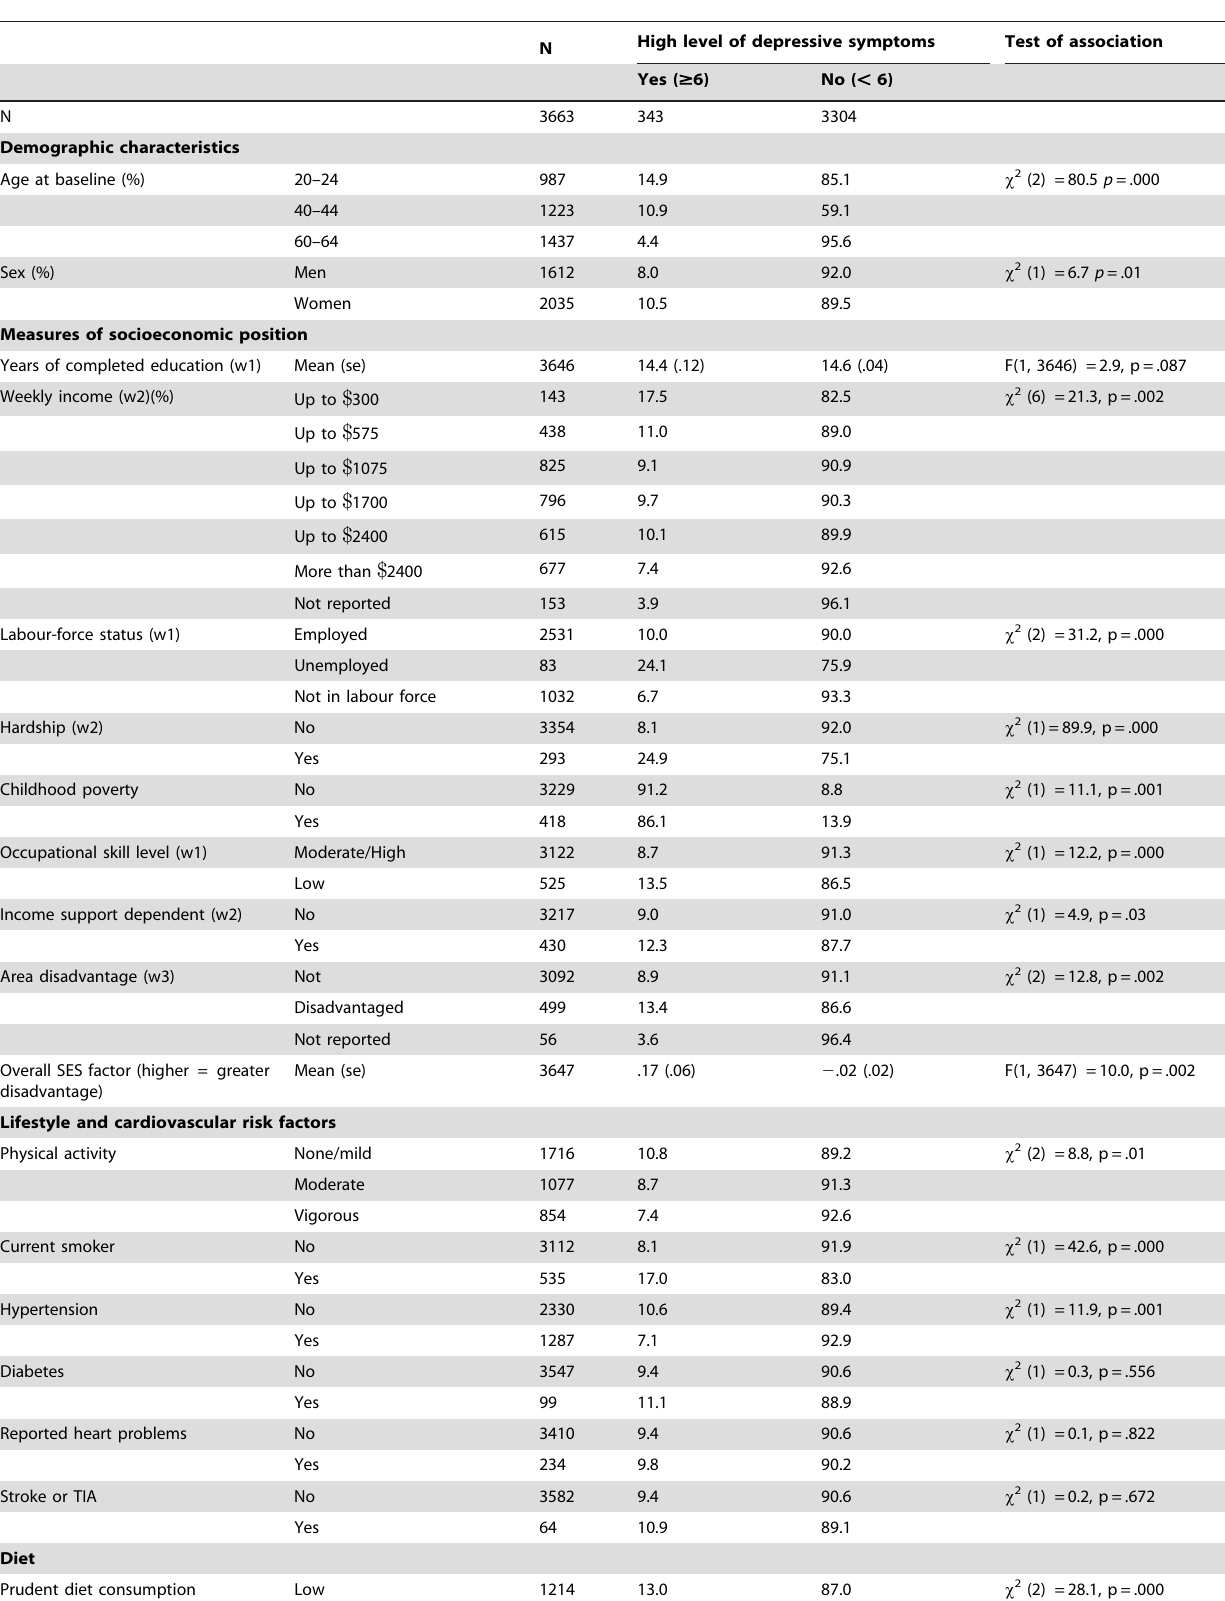
Table 1. Baseline demographic, socioeconomic, lifestyle and diet characteristics of the sample.